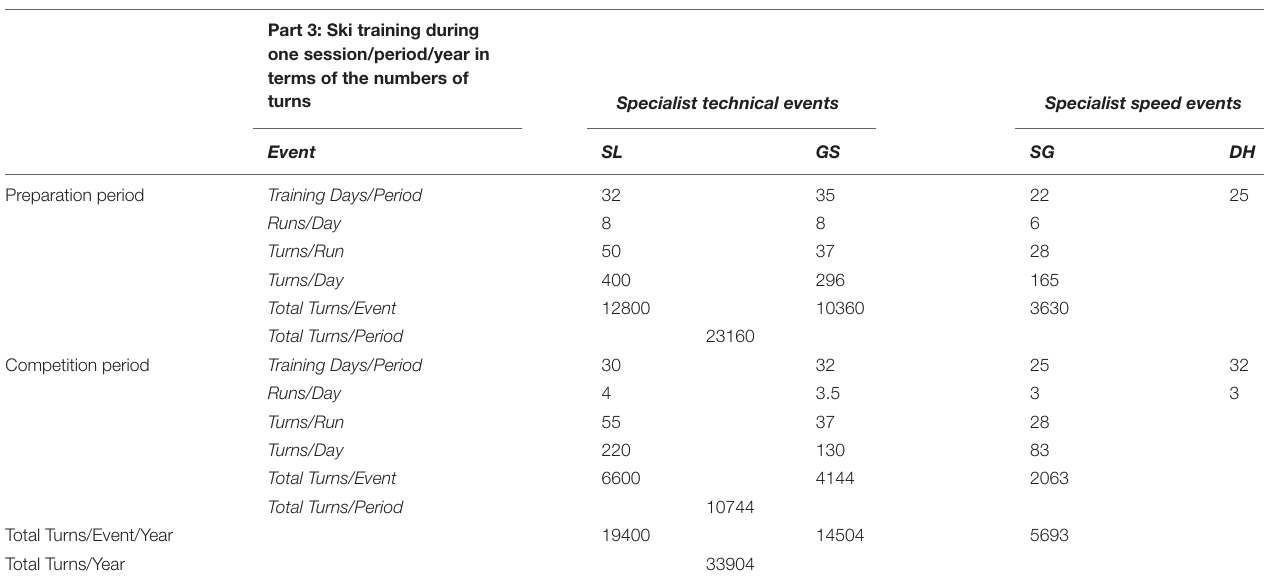
Part 1: The content of one session of ski training during the preparation and competition